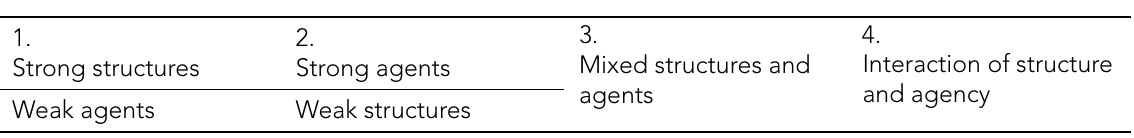
Table 2. Structures and agents (Source: author)